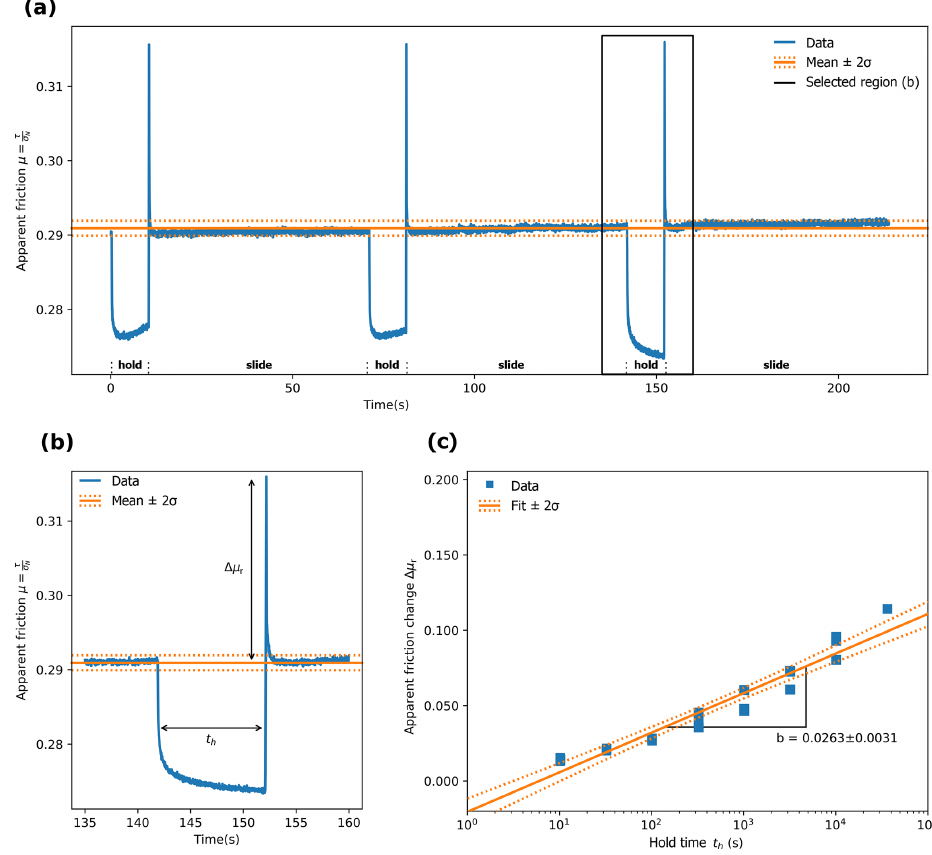
Figure 1. Time series of one slide–hold–slide sequence and picked values. (a) Slide–hold–slide sequence of GFZ 70–110µm glass beads for t h = 10s. Slide and hold phases are marked along the time axis. (b) Detailed time series showing a single hold phase and the picked value for (cid:49)µ r . (c) Fit of all picked reloading friction values versus hold time. The error ranges are the 95% confidence bands for the fit.